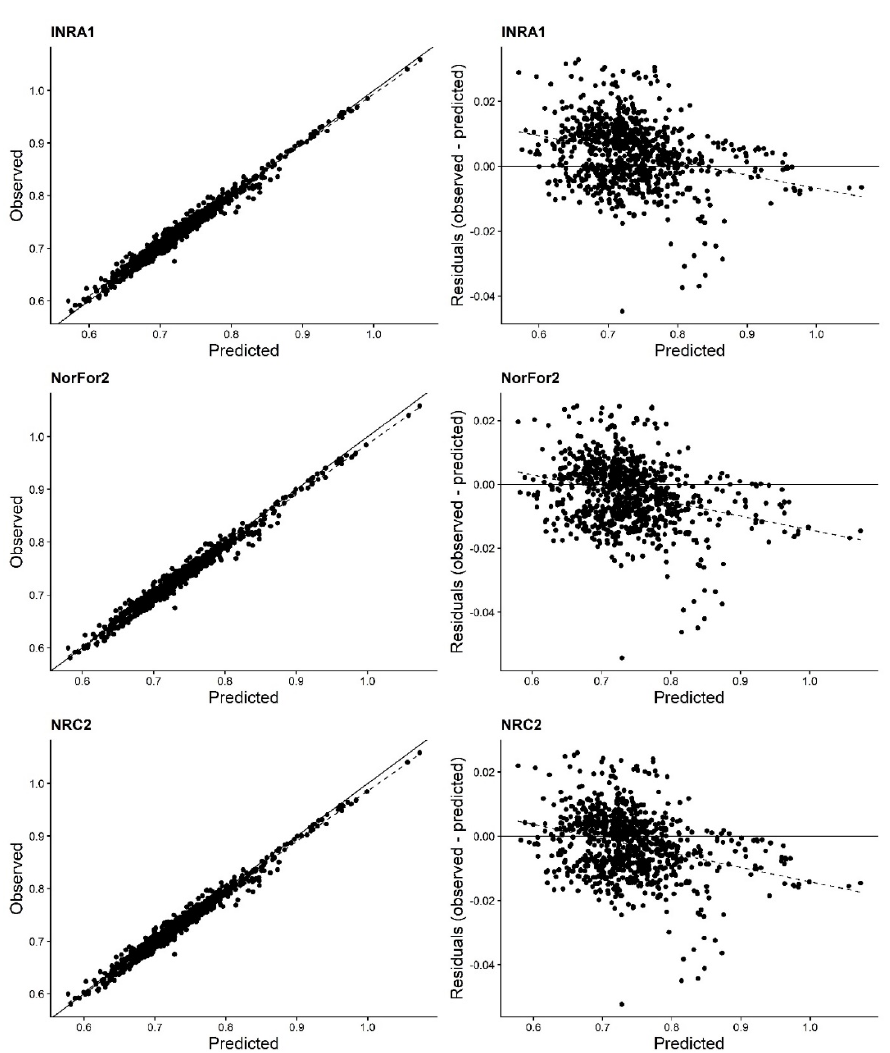
Figure 2. Plots of observed versus predicted milk energy (Mcal/L) and observed minus predicted (residual) versus predicted milk energy (Mcal/L) using Tier 2 equations. The dotted lines represent the regression lines. INRA, Institut National de la Recherche Agronomique; NorFor, Nordic feed evaluation system (Scandinavia); NRC, National Research Council. Tier 3 equations, which used only one variable, milk fat, were included in the NRC, CNCPS, CSIRO, and Japan feeding systems. The Tier 3 equations also showed high pre- diction ability (R 2 = 0.96, RMSEP = 0.02). The CNCPS equation had the lowest RMSEP of 0.01 (2.03% of the observed mean) and the highest CCC value (0.97, Table 4). Random bias accounted for most of the bias in all equations (Table 4). Among the Tier 3 equations, the CNCPS, Japan, and NRC equations showed a negative trend when the predicted milk energy values were lower than 0.69, 0.68, and 0.83 Mcal/kg, respectively, and then a posi- tive residual beyond that. The CSIRO equation showed a positive trend when milk energy values were lower than 0.98 Mcal/kg and a negative residual when they were higher than that (Figure 3).